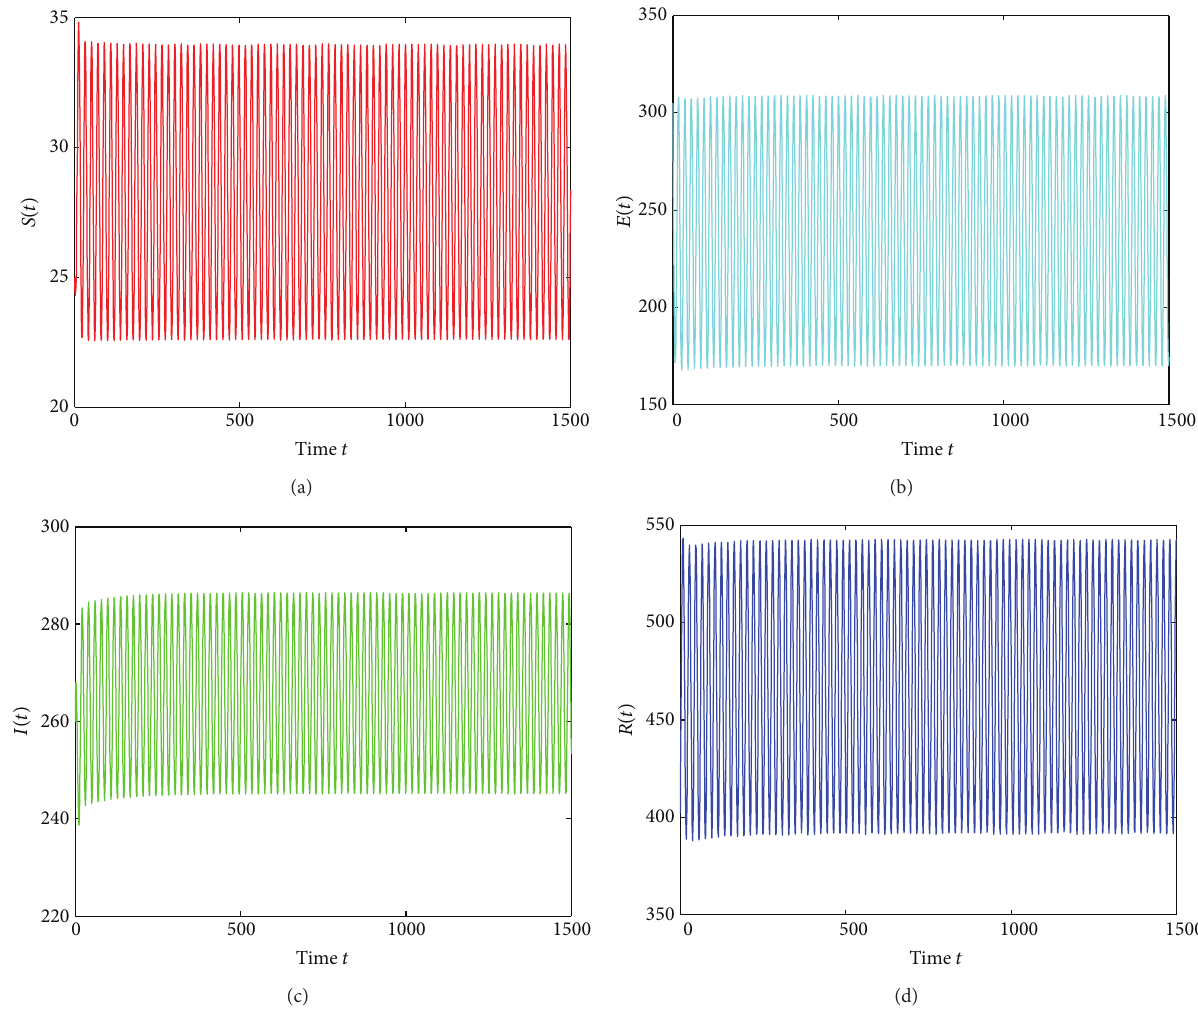
Figure 11: The track of the states 𝑆 , 𝐸 , 𝐼 , and 𝑅 for 𝜏 = 5.2300 > 5.1094 = 𝜏 0